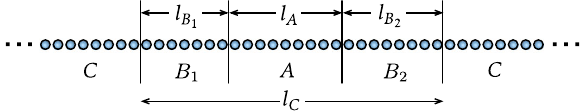
FIG. 1. The basic partitioning of the system for the proof. Here, ≤ l l as a convention. We let l B 1 B 2 Note that l is defined to be l C